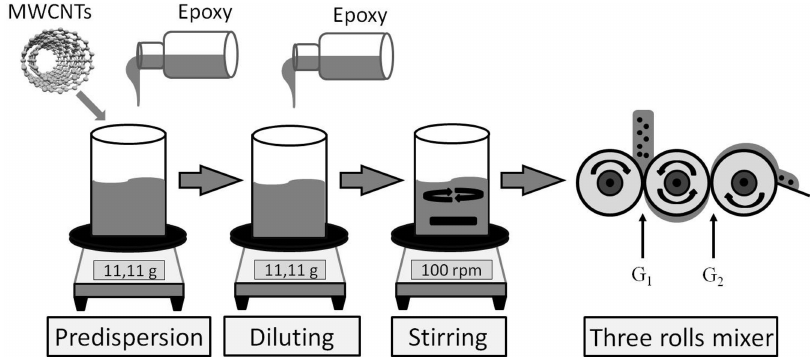
Figure 2. Preparation processes of the MWCNT-epoxy